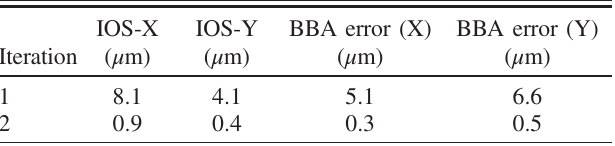
TABLE II. Standard deviations of residual IOS at BPMs and the differences between the BBA results and the actual